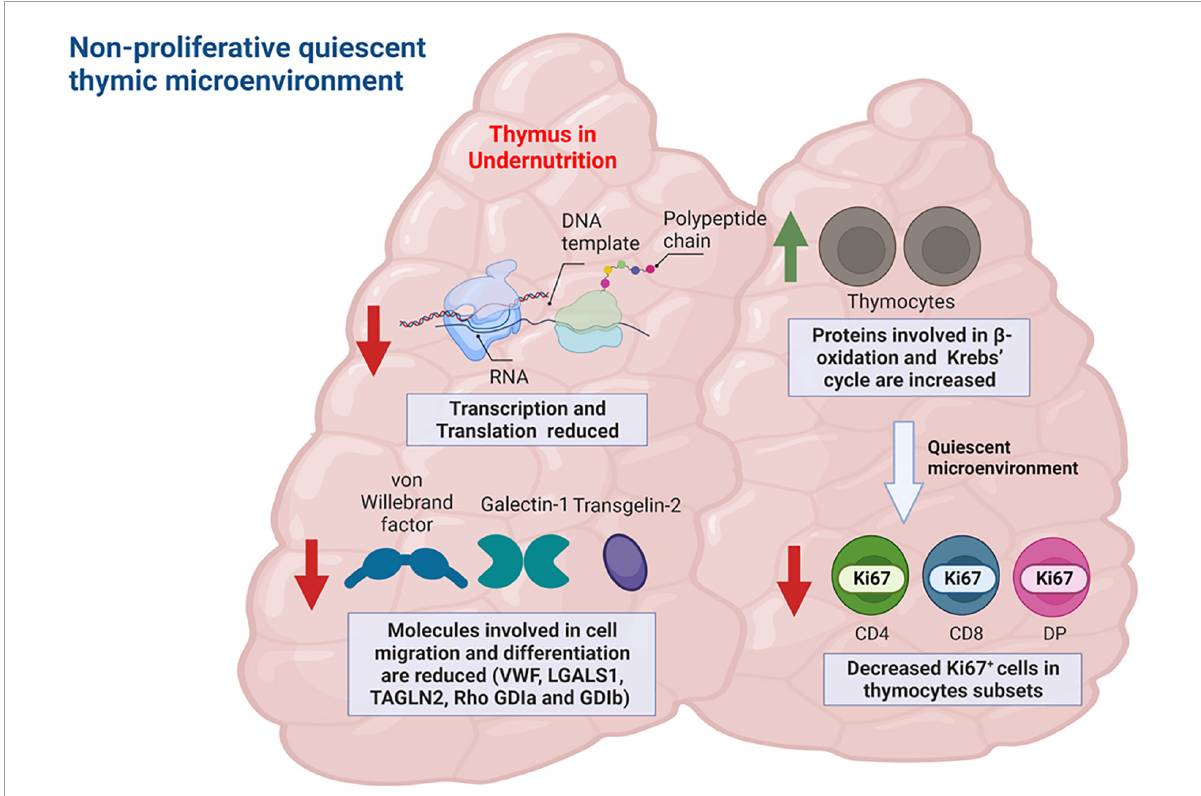
FIGURE4 Quantitative proteomics analysis of thymic interstitial fluid of undernourished-infected mice reveals a non-proliferative quiescent thymic microenvironment. Examples of proteins with differential abundance in the undernourished-infected mice relative to the control (well-nourished) mice are represented in the figure. Proteins involved in transcription and translation as well as proteins involved in cell migration and differentiation were reduced in undernourished mice (red arrows). Conversely, proteins involved in fatty acid beta-oxidation and Krebs’ cycle were increased in those animals (green arrow), compatible with a quiescent, non-proliferative metabolic profile. Such profile was corroborated by a decreased percentage of proliferating thymocyte subsets expressing Ki67. Figure created with BioRender.com, based on data from Losada-Barragán et al.